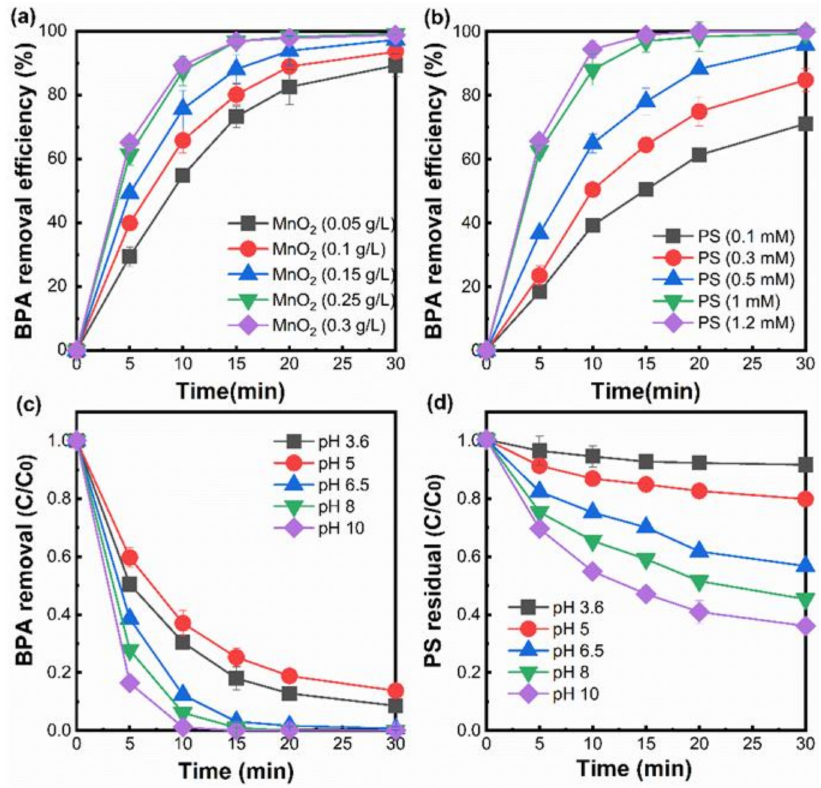
Figure 2. Effects of ( a ) MnO 2 dosages, ( b ) PS concentration, and ( c ) pH level on BPA removal, and PS residual in different pH levels ( d ). Conditions at t = 0 min: [BPA] = 30 mg/L, pH in ( a ) and ( b ) = 6.5, [PS] in ( a ) and ( c ) = 1 mM, [MnO 2 ] in ( b ) and ( c ) = 0.25